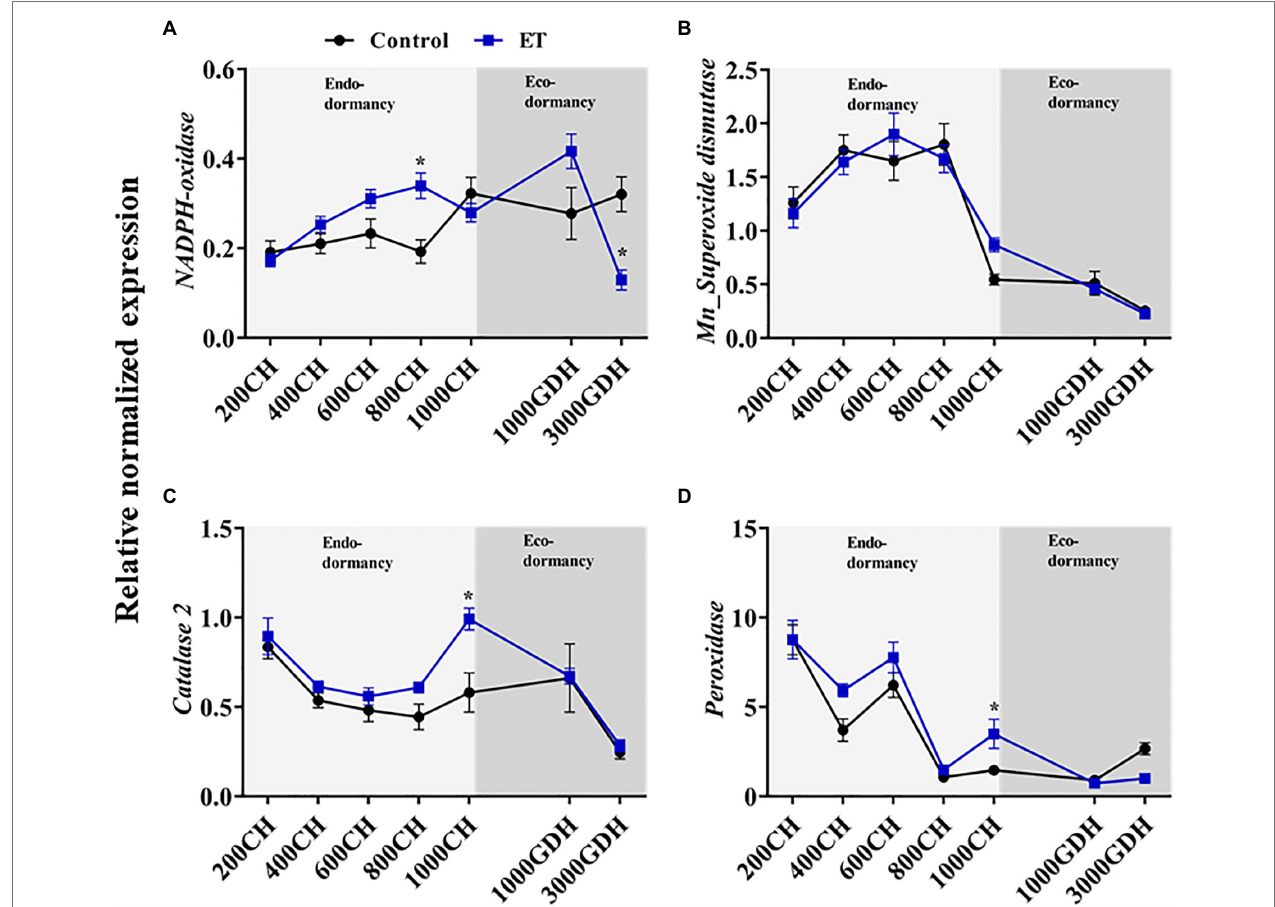
FIGURE 3 | Ethephon (ET)-mediated changes of the antioxidative-related genes expression in peach “Red haven” flowering buds during the dormancy. NADPH- oxidase (A) , Mn_superoxide dismutase ( Mn_SOD ; B) , catalase 2 ( CAT2 ; C) , and glutathione peroxidase ( Gpx ; D) . Data represent the mean ± SEM for n = 3. Asterisks indicate significant differences between the control and ET-treated plant buds at different chilling hours (CH) and GDH; ∗ p <